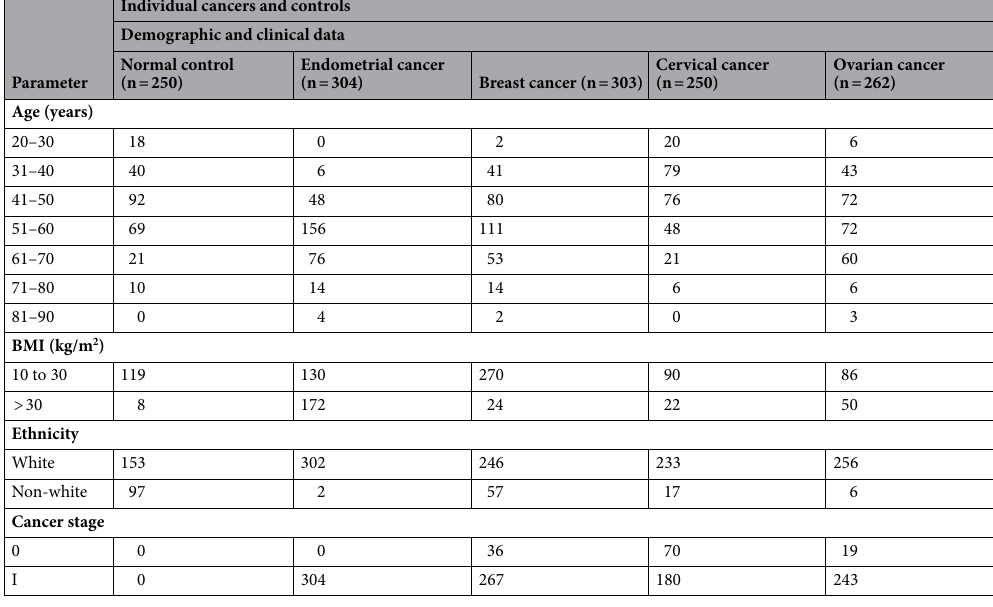
Table 1. Demographic, ethnicity, and BMI group of the sample set used in the